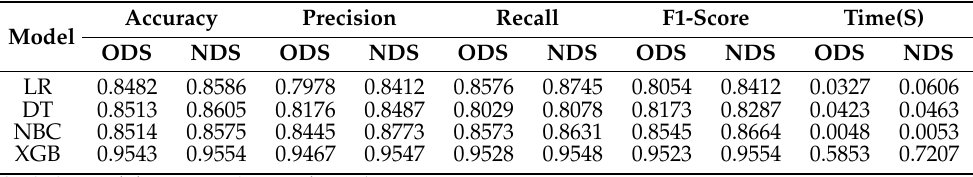
Table 4. Model performance comparison on different datasets.